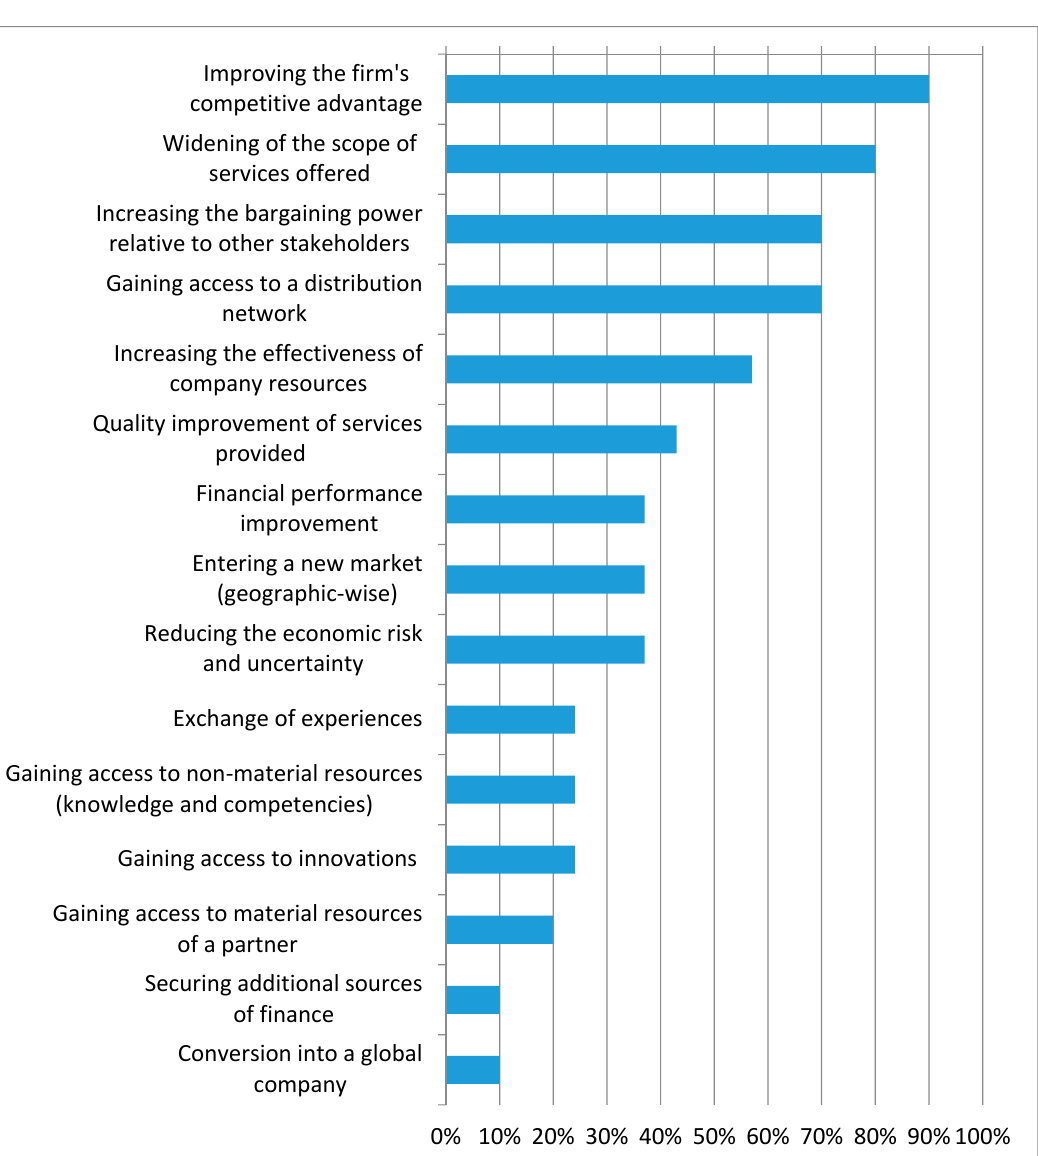
Figure 6. Origin of capital in firms forming strategic alliances.